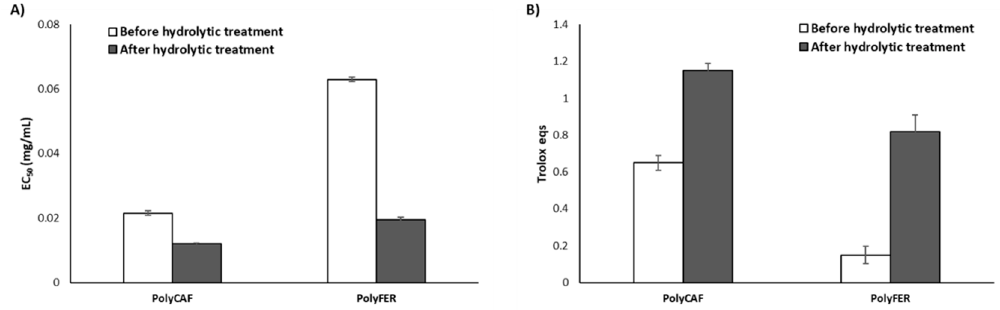
Figure 5. Antioxidant properties of PolyCAF and PolyFER before and after hydrolytic treatment. ( A ) DPPH assay; ( B ) FRAP assay. Reported are the mean ± SD values of at least three experiments.